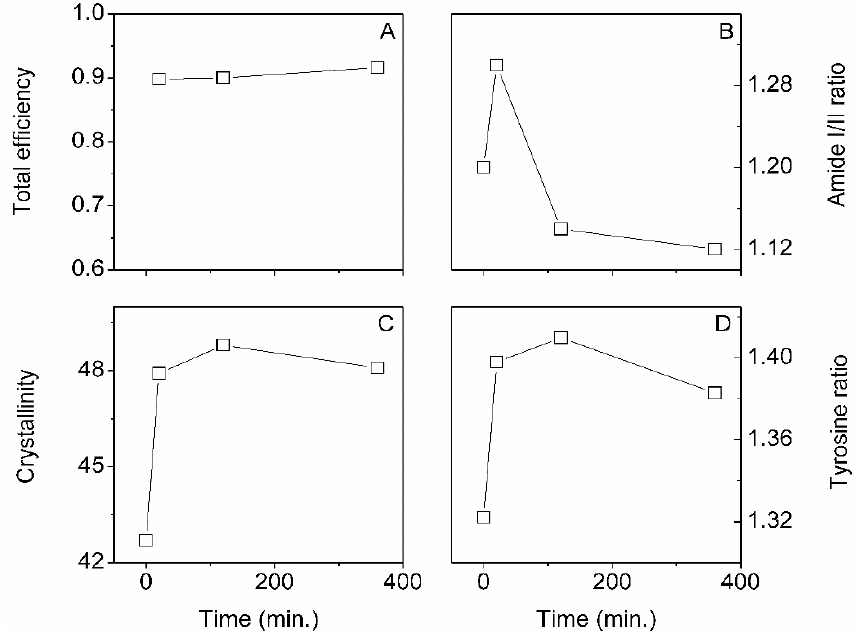
Figure 9. Effect of increasing scCO 2 impregnation time on total efficiency ( A ), Amide I/II ratio ( B ), Crystallinity ( C ), and Tyrosine ratio ( D ). The gold NP concentration was kept constant at 0.1 O.D.